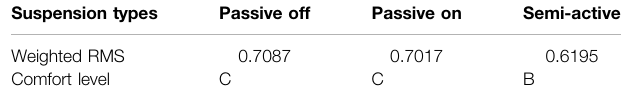
TABLE 2 | The weighted RMS values of accelerations for the three suspensions. Suspension